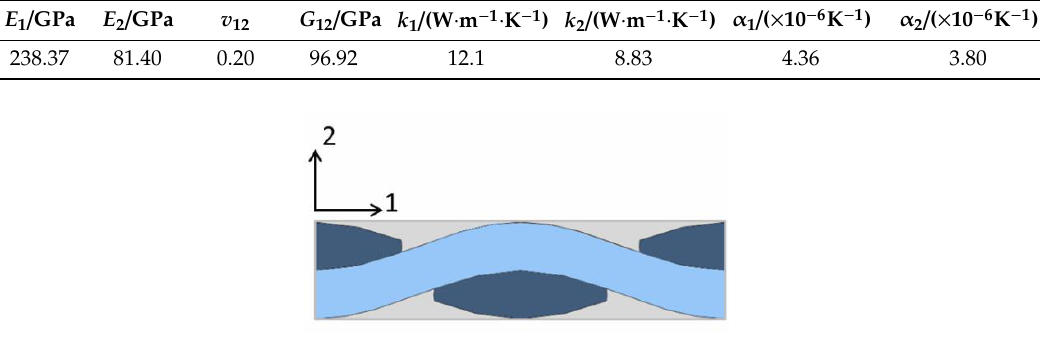
Figure 1. Microstructure of 2D woven SiC/SiC composites.